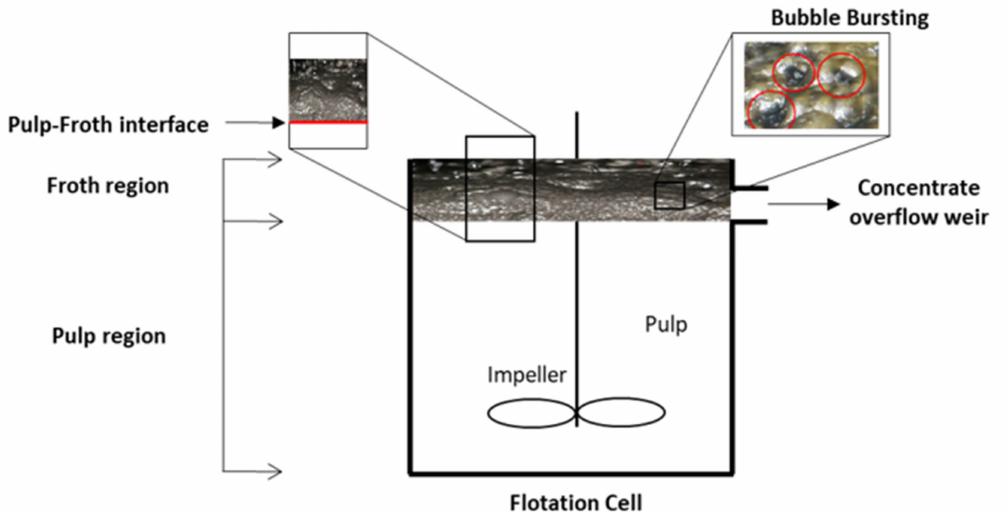
Figure 8. Schematic explaining the two main regions (pulp and froth) in a flotation cell and the bubble bursting in the froth zone and relevant literature in each region from rheology point of view. The image on bubble bursting was obtained from Otsuki and Miller (2018) adapted from